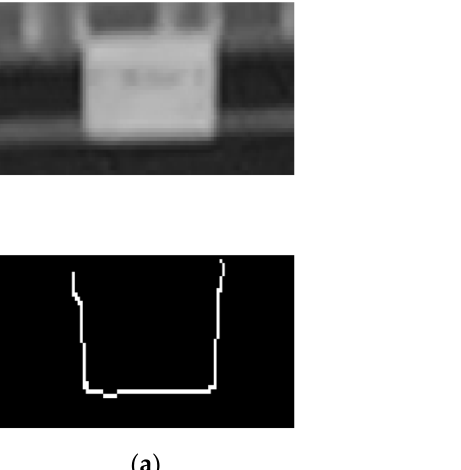
Figure 7. Motion extraction using edge detection: ( a ) Canny’s edge detector; ( b ) estimated displacement at roof.